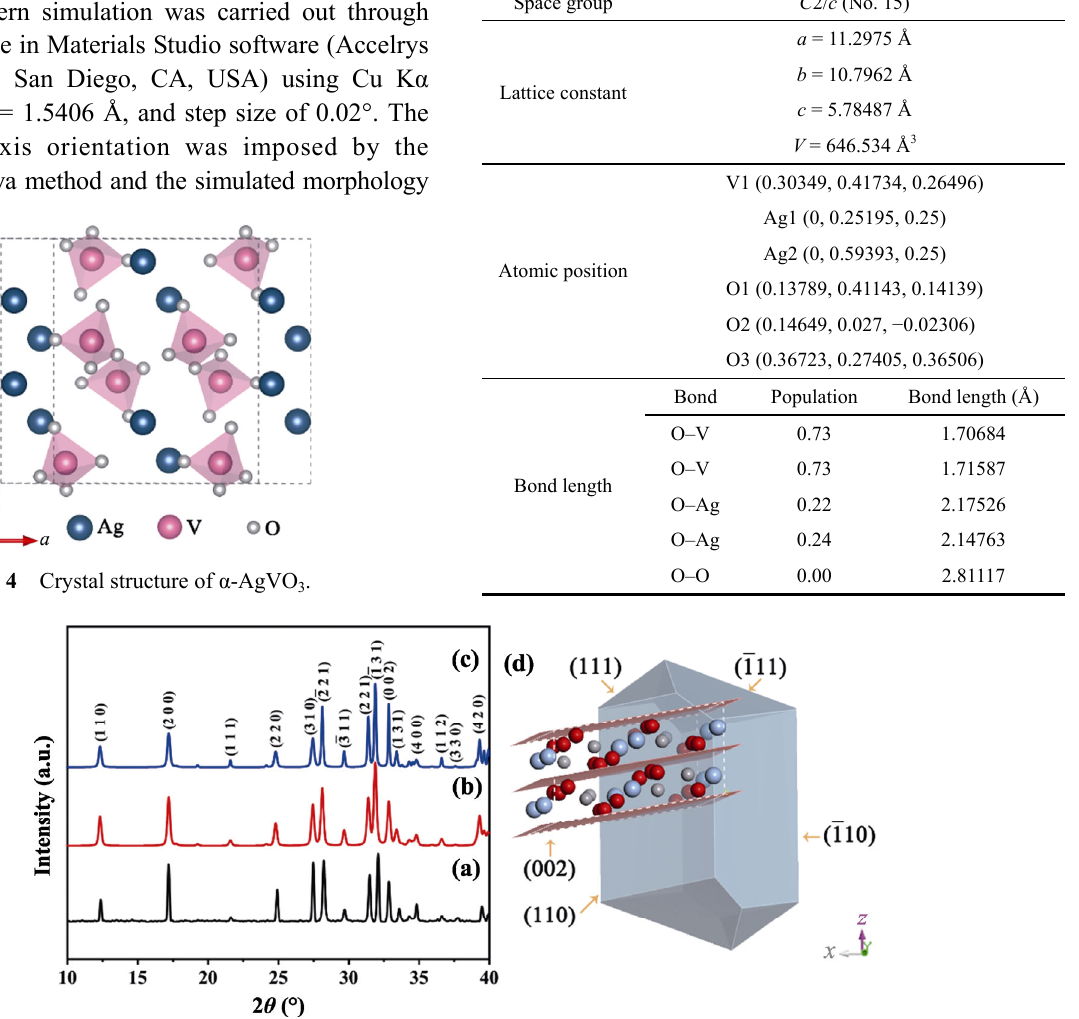
Fig. 5 (a) Experimental XRD patterns of α -AgVO 3 , together with simulated XRD patterns of (b) powder and (c) c -axis oriented particle, and (d) morphology of α -AgVO 3 generated based on the theory of Donnay–Harker (in the crystal structure of α -AgVO 3 , (002) plane is